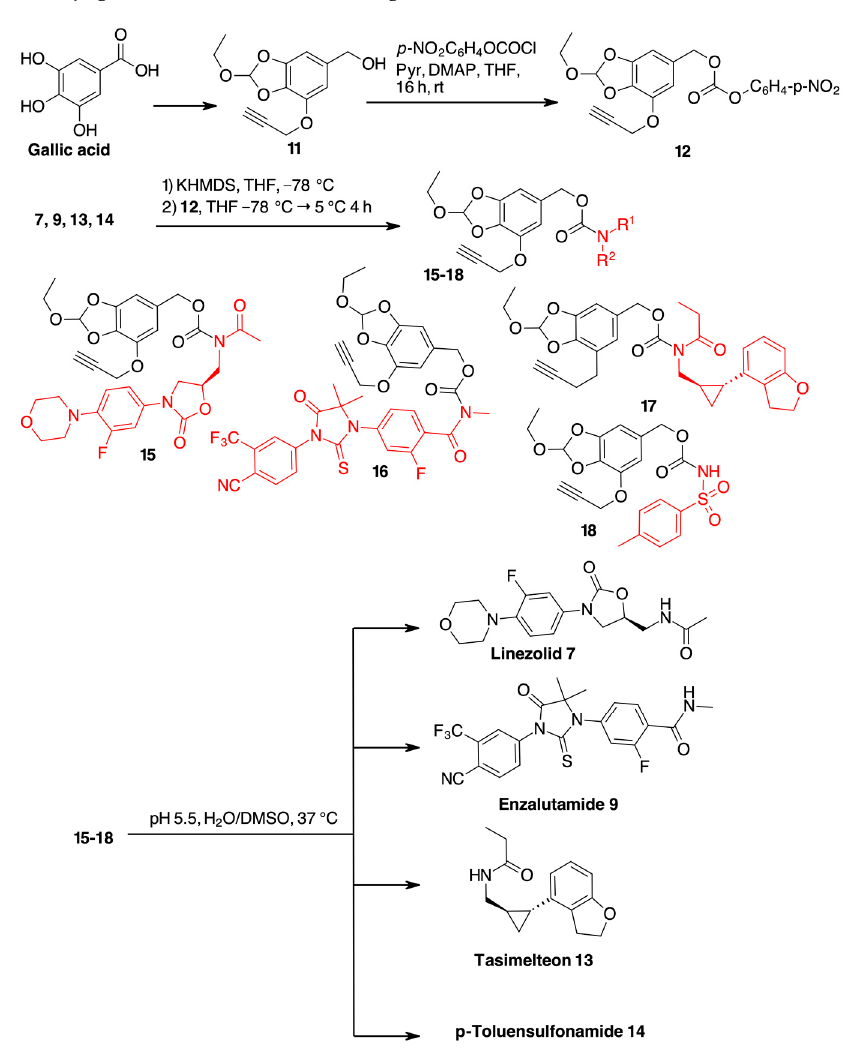
Figure 1. Qualitative analysis of payload release of acylamido carbamates 15 – 18 . Release conditions are reported in the Materials and Methods section and in Supplementary